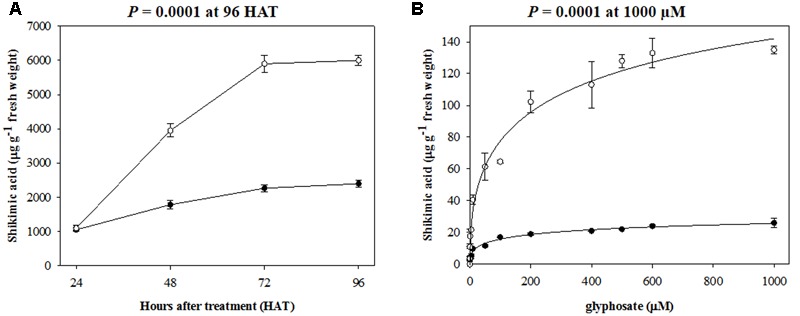
Shikimic acid accumulation in (A) plant leaves, and (B) leaf segments of plants from R (•) and S (∘) biotypes of rigid ryegrass. Symbols denoted mean (n = 5) ± standard errors of the mean.